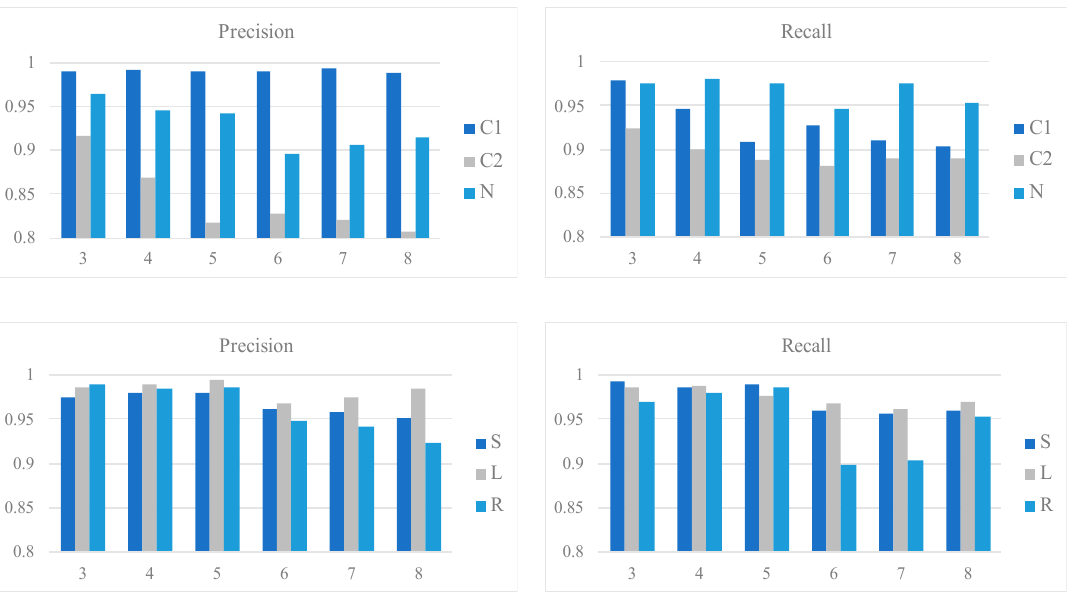
Figure 6. Class-wise performances of the qua_models and pos_models for the 2 s signal. The upper two bar plots show the precision and recall of the qua_models; whereas the lower two show those of the pos_models. The x-axis in each plot corresponds to the number of Conv layers.